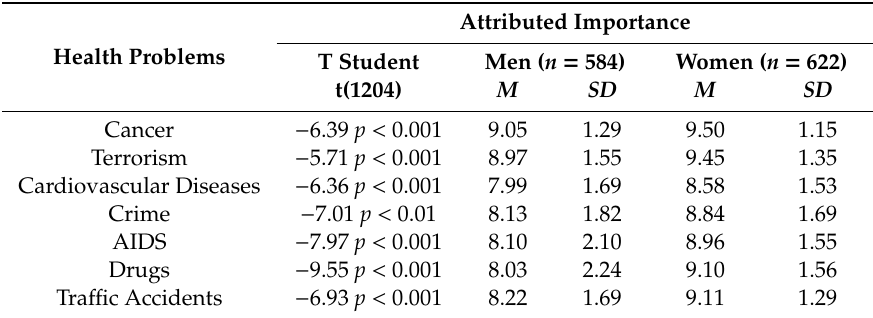
Table 3. Valuation of importance and figures of social and health problems according to sex.